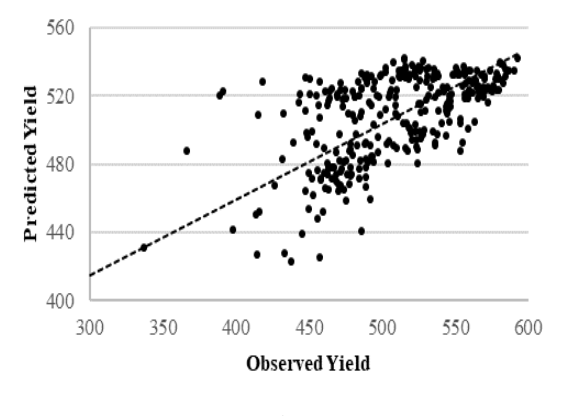
Figure 6. Russet potato fields yield model results